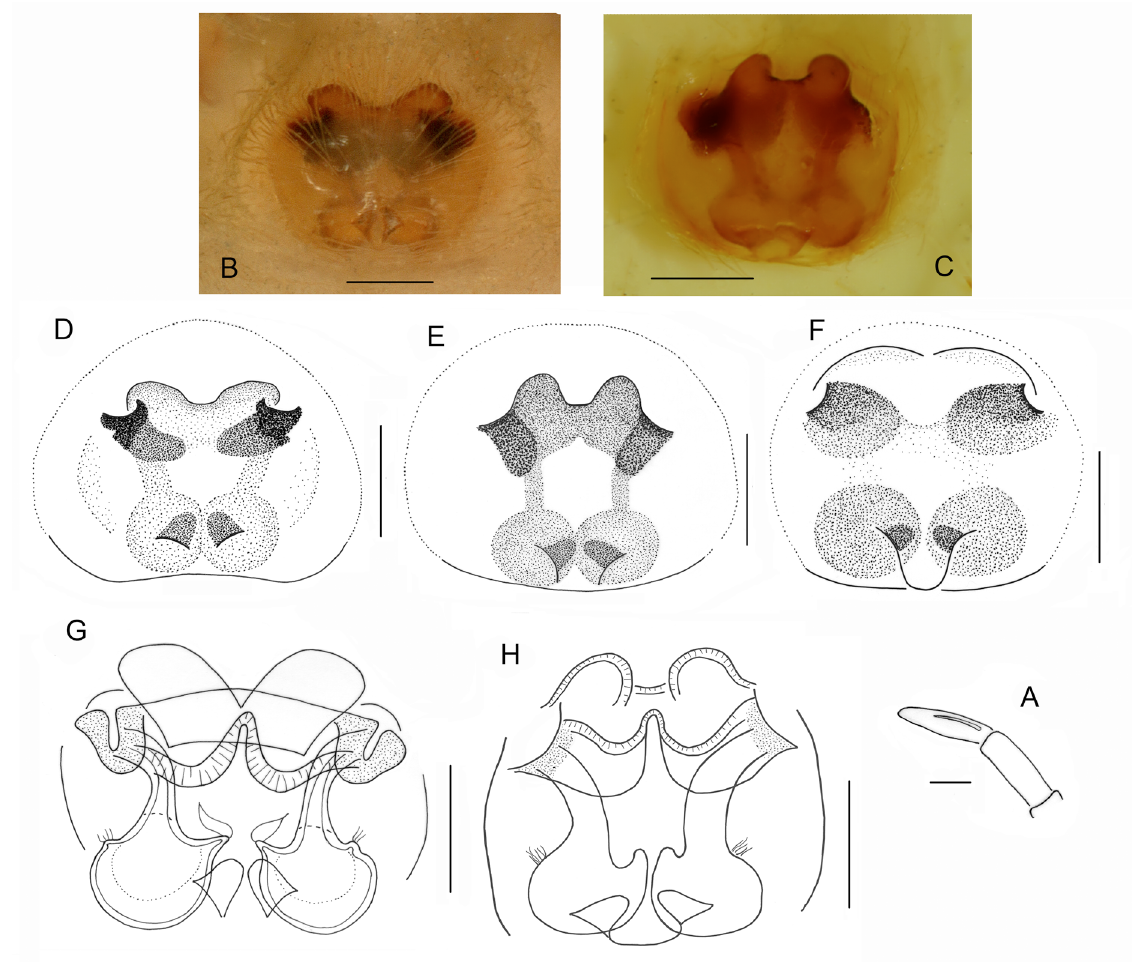
Fig. 10. Pochytoides poissoni (Berland & Millot, 1941) comb. nov., holotype, ♀ (B, D, G), specimen from Ziéla (A, C, e, H) and specimen from Fouenyi (F). A . Tip of female’s palp. B–F . Epigyne. G – H . Internal structure of epigyne. scale bars: A = 0.3 mm, B–H = 0.2